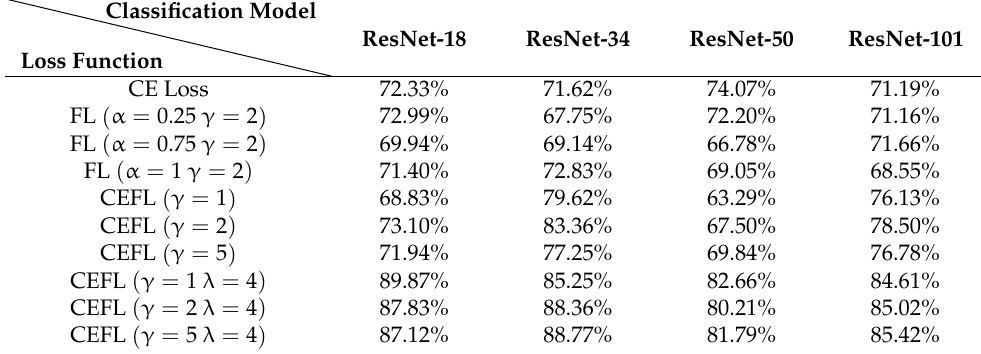
Table 5. Recall rates based on different loss functions of various ResNets.